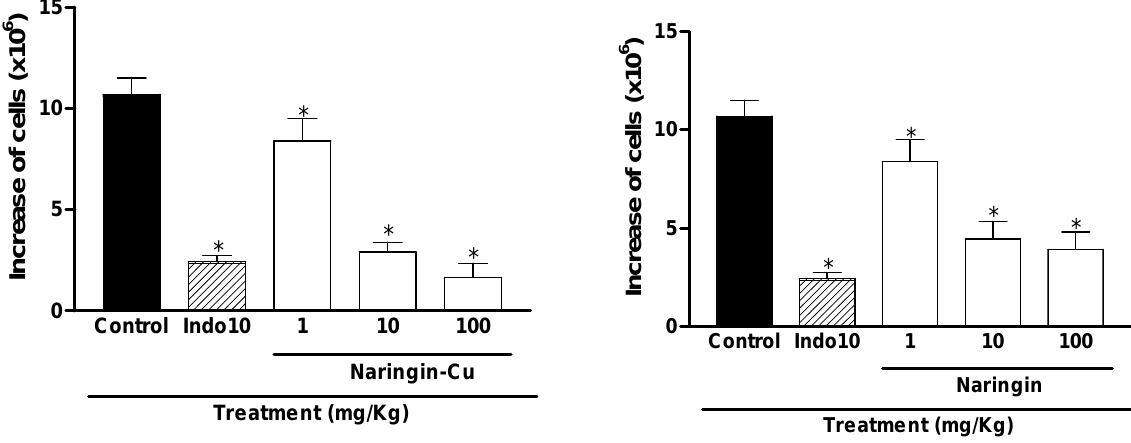
Figure 6. Effect of the administration of Complex 1 (Naringin-Cu) or Naringin (1-100 mg/kg, i.p. or 10 mg/kg indomethacin, i.p.) in the acute carragenan-induced inflammatory reaction measured by the concentration of cells in the peritoneal fluid. Each value represents the mean ± S.E.M. of 6 animals, and asterisks indicate significant inhibition of total number of cells in the peritoneal cavity in relation to the untreated groups, P <